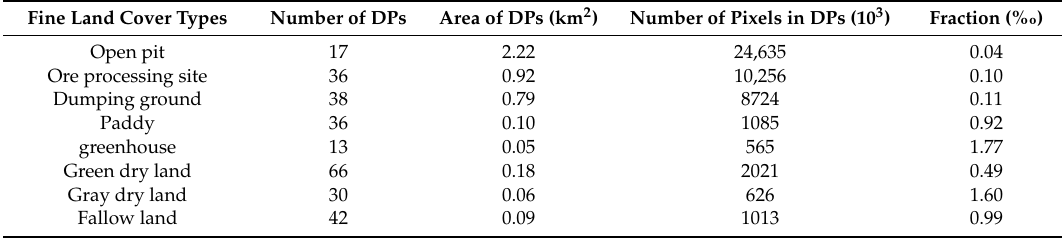
Table 4. Description of the Training Set and Test Set Used in This